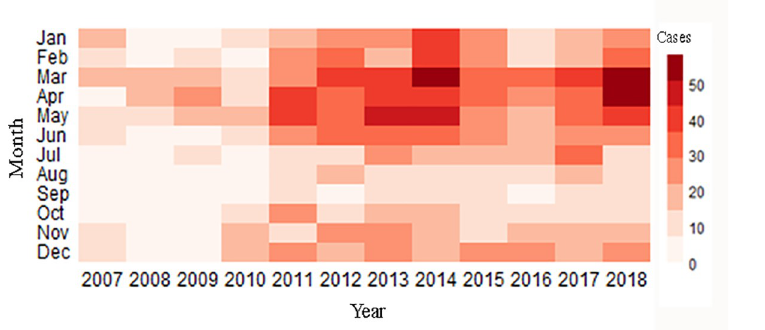
Fig 3. Monthly distribution of HFRS